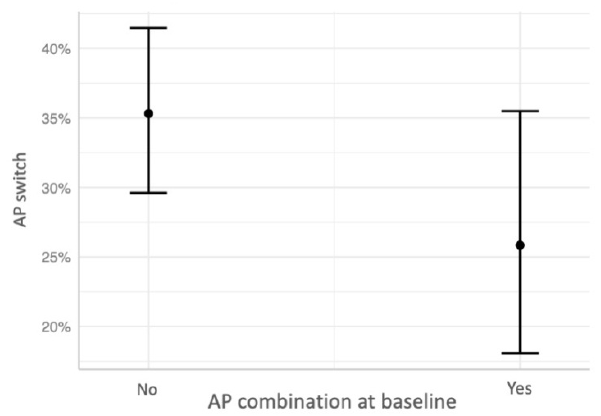
Figure 1. Predicted probabilities of antipsychotic (AP) switch associated with APs combination at baseline.